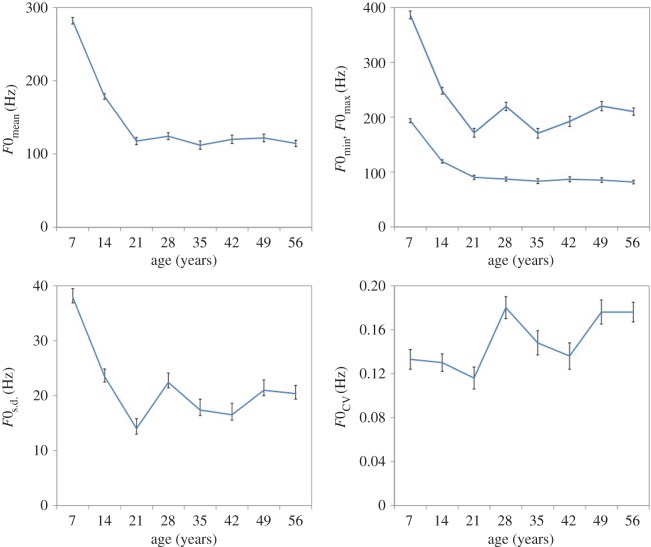
Mean fundamental frequency (F0) parameters for males at each age. Error bars represent the standard error of the mean.